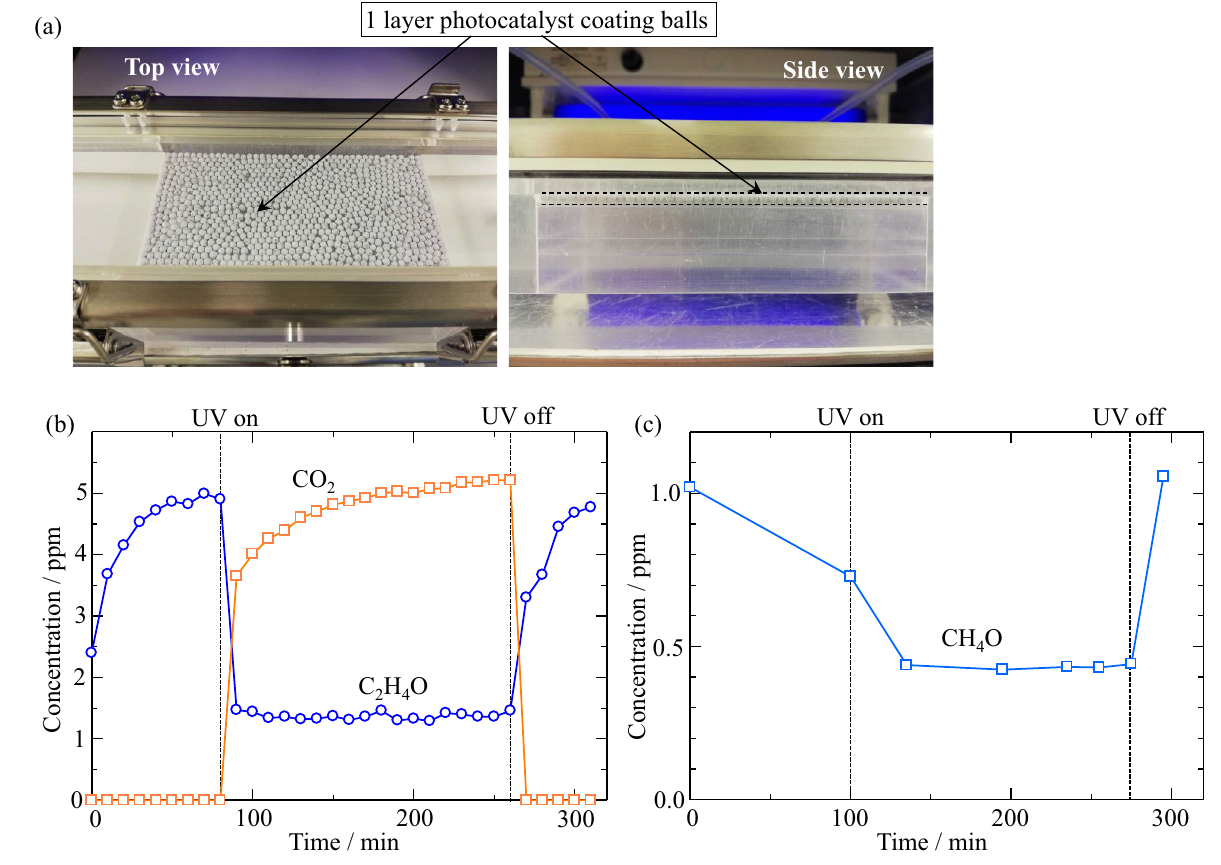
Figure 3. The decomposition test of C 2 H 4 O and CH 2 O with the TiO 2 /Ti–O sample. ( a ) the set-up, ( b ) the concentration changes of C